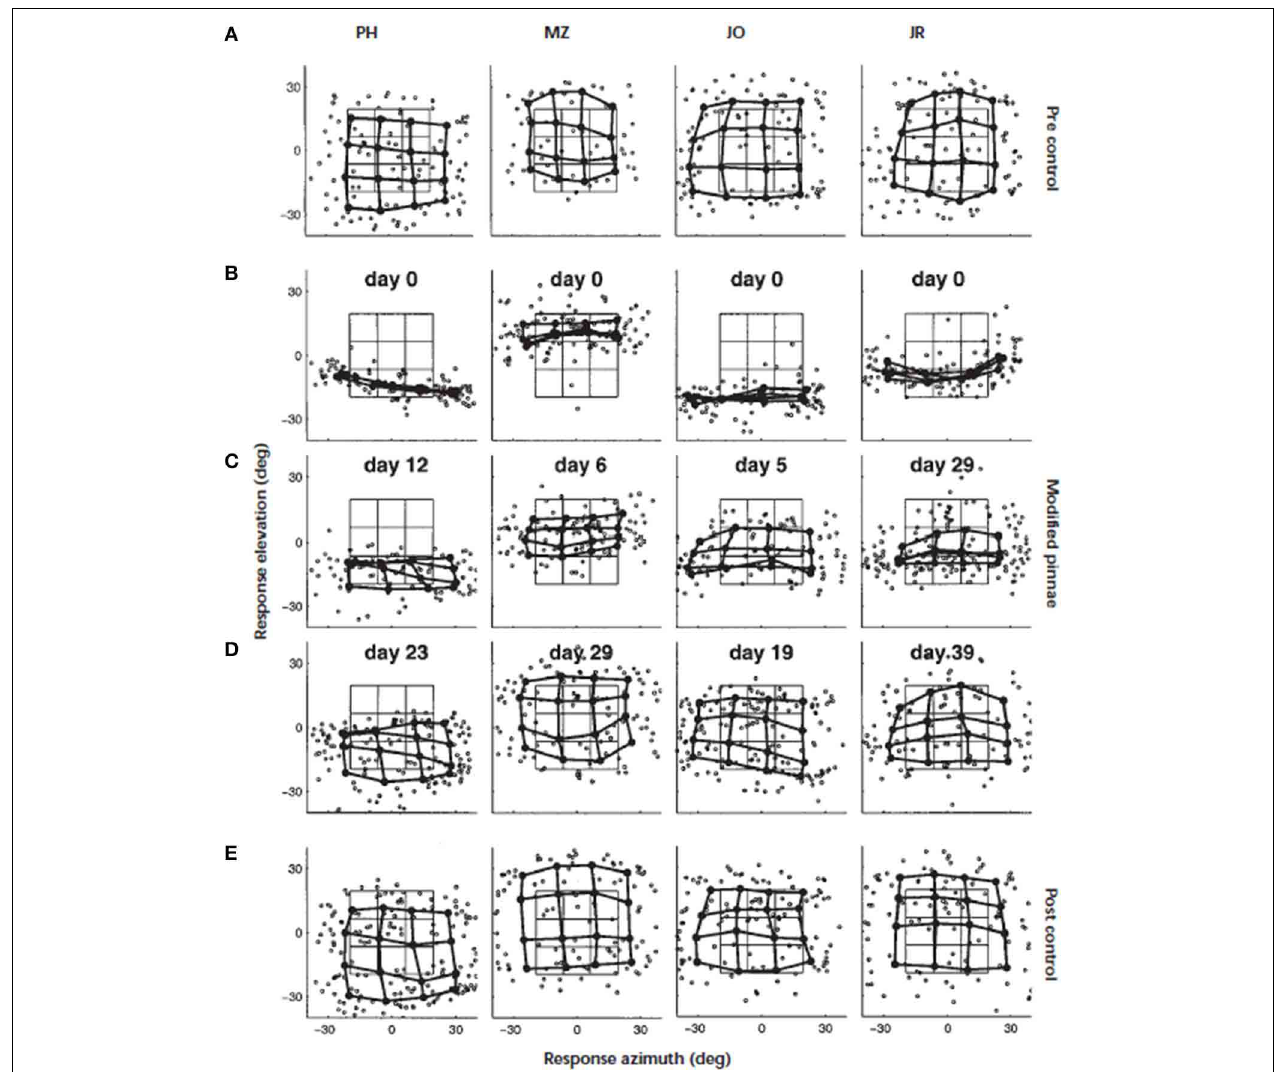
FIGURE 3 | Adaptation to altered spectral cues. Localization behavior of four subjects (from left to right) before, during, and immediately after the adaptation period. Day 0 marks the start of the adaptation experiment. The panels show, for each subject, the individual saccade vector endpoints in the azimuth–elevation plane (symbol ◦ ). In addition, the saccade vectors were also averaged for targets belonging to similar directions by dividing the target space into 16 half-overlapping sectors. Averaged data points (solid circle) from neighboring stimulus sectors are connected by thick lines. In this way, a regular response matrix indicates that the subject’s saccade endpoints capture the actual spatial distribution of the applied target positions. The target matrix, computed in the same way as the saccade matrix, has been